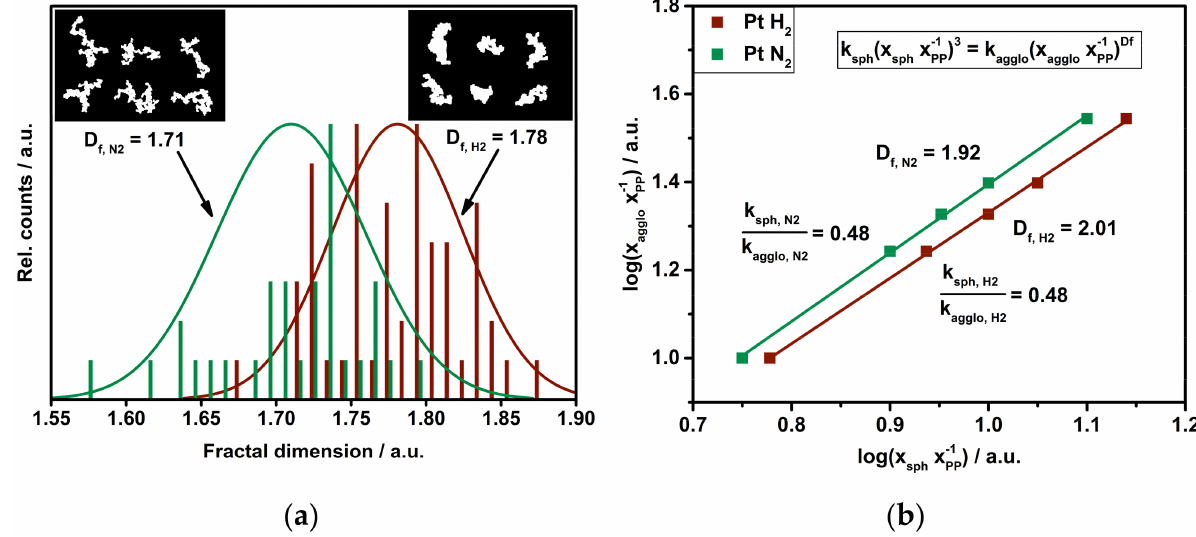
Figure 7. Fractal dimension of platinum particles under nitrogen and after exposure to hydrogen: ( a ) D f estimation by TEM based on the determination of the radius of gyration. The insert shows binary TEM micrographs used for image analysis by ImageJ ® . ( b ) Log-log plot of pre-classified platinum particles with an agglomerate size of x agglo at room temperature, a primary particle size x PP and spherically sintered particle size x sph at 1150 ◦ C. The slope of the linear fit equals 3/D f . Error bars are within the